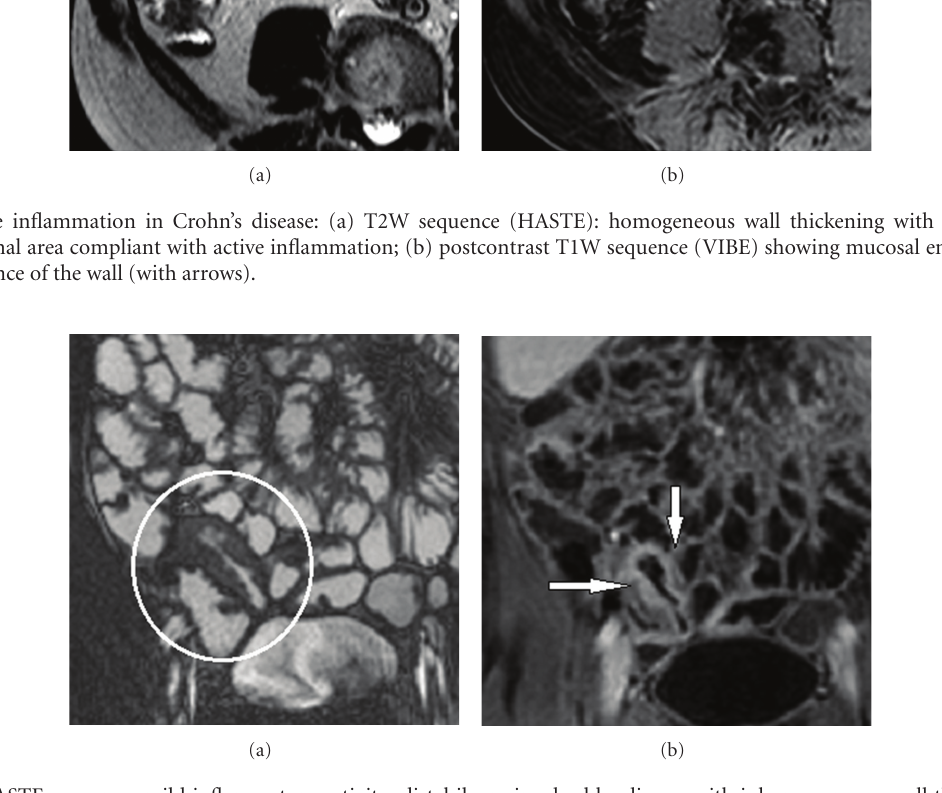
Figure 4: (a) HASTE sequence: mild inflammatory activity; distal ileum involved by disease with inhomogeneous wall thickening (white circle) (b) T1-weighted sequence (VIBE): postcontrast homogenous wall enhancement compliant with fibrotic evolution and reduced inflammatory activity (white